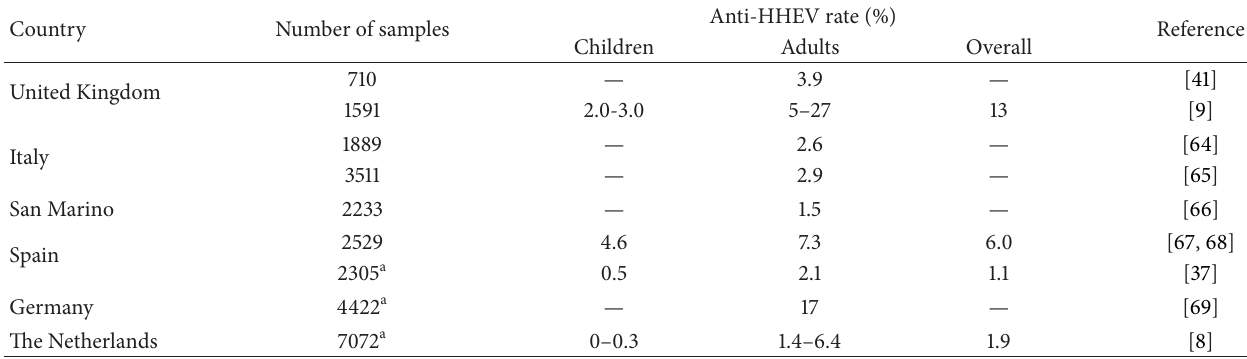
Table 1: Prevalence of anti-HHEV among the general population of Europe.